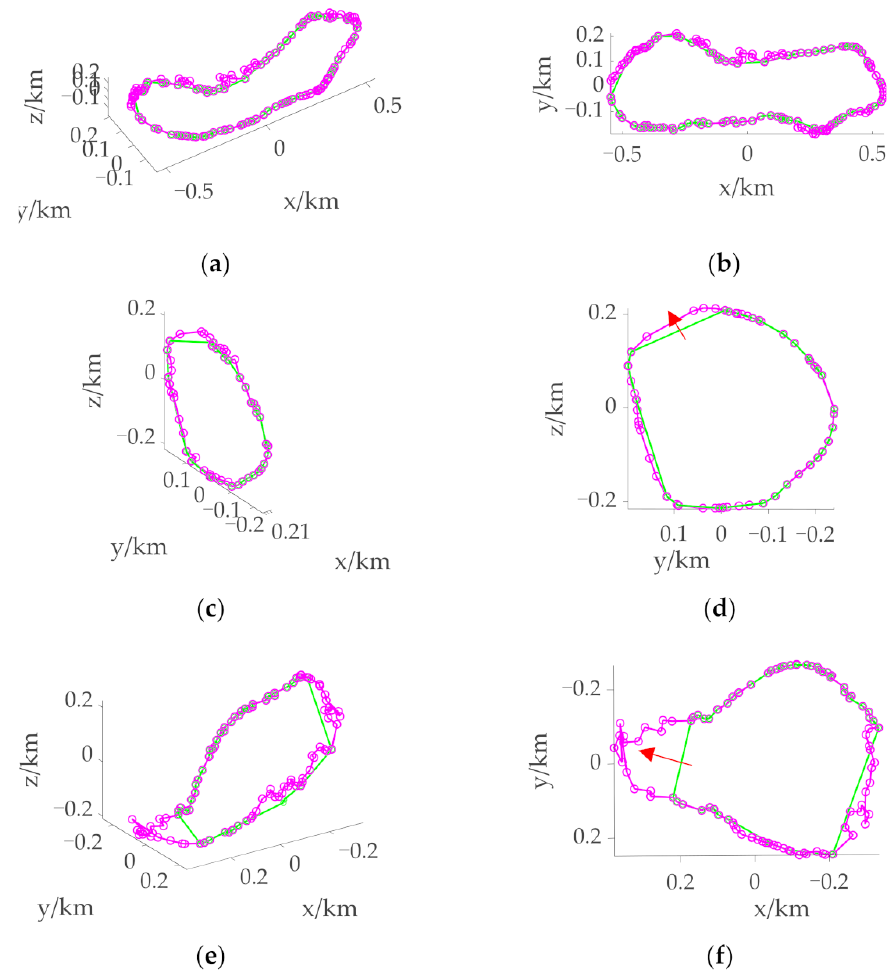
Figure 12. Boundary of the reachable domain under different initial states with t f = 1000 s. ( a ) 3D view of the boundary when the initial position is over the North Pole. ( b ) Supplementary view of the boundary when the initial position is over the North Pole. ( c ) 3D view of the boundary when the initial position is over the Equator. ( d ) Supplementary view of the boundary when the initial position is over the Equator. ( e ) 3D view of the boundary when the initial position is over the mid-latitude region. ( f ) Supplementary view of the boundary when the initial position is over the mid-latitude region. The green connecting line stands for the initial boundary. The purple connecting line stands for the continuous boundary. The red arrow stands for the direction of